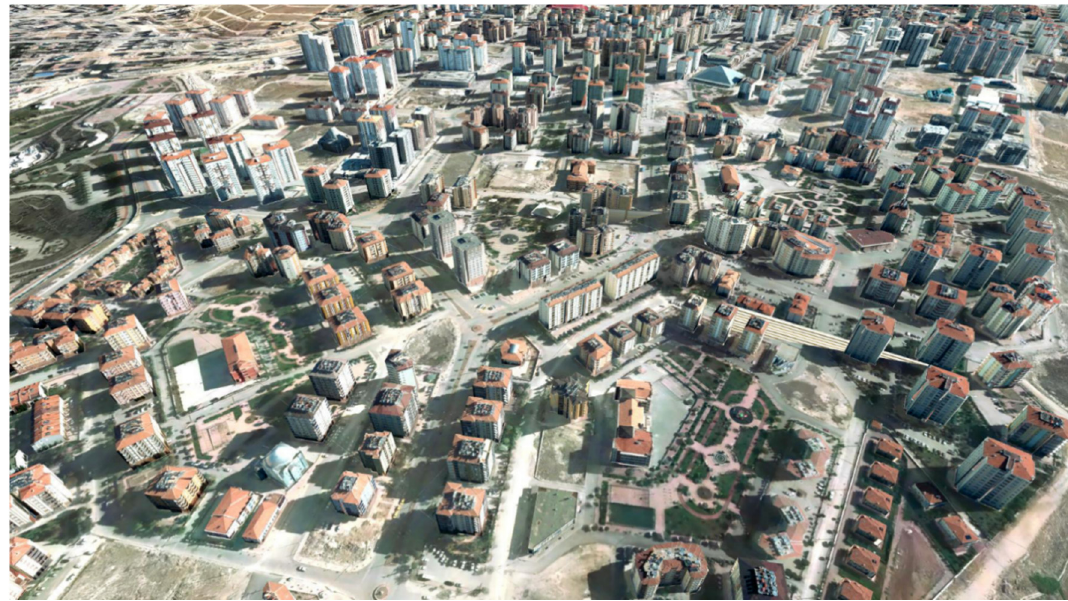
Figure 5. Unity Game Engine visualization of the textured LoD2 model together with the DTM and the true-orthophoto basemap.